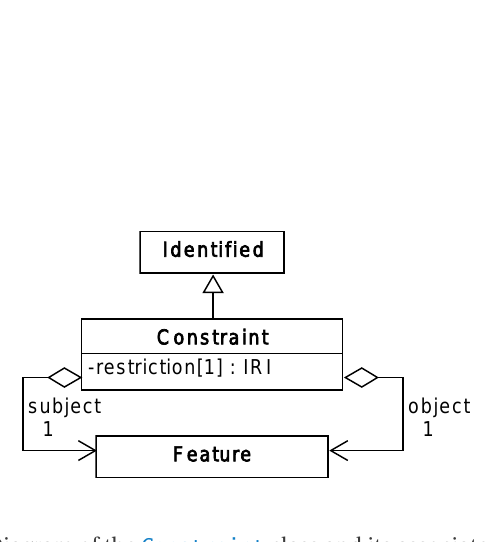
Figure 11: Diagram of the Constraint class and its associated properties.